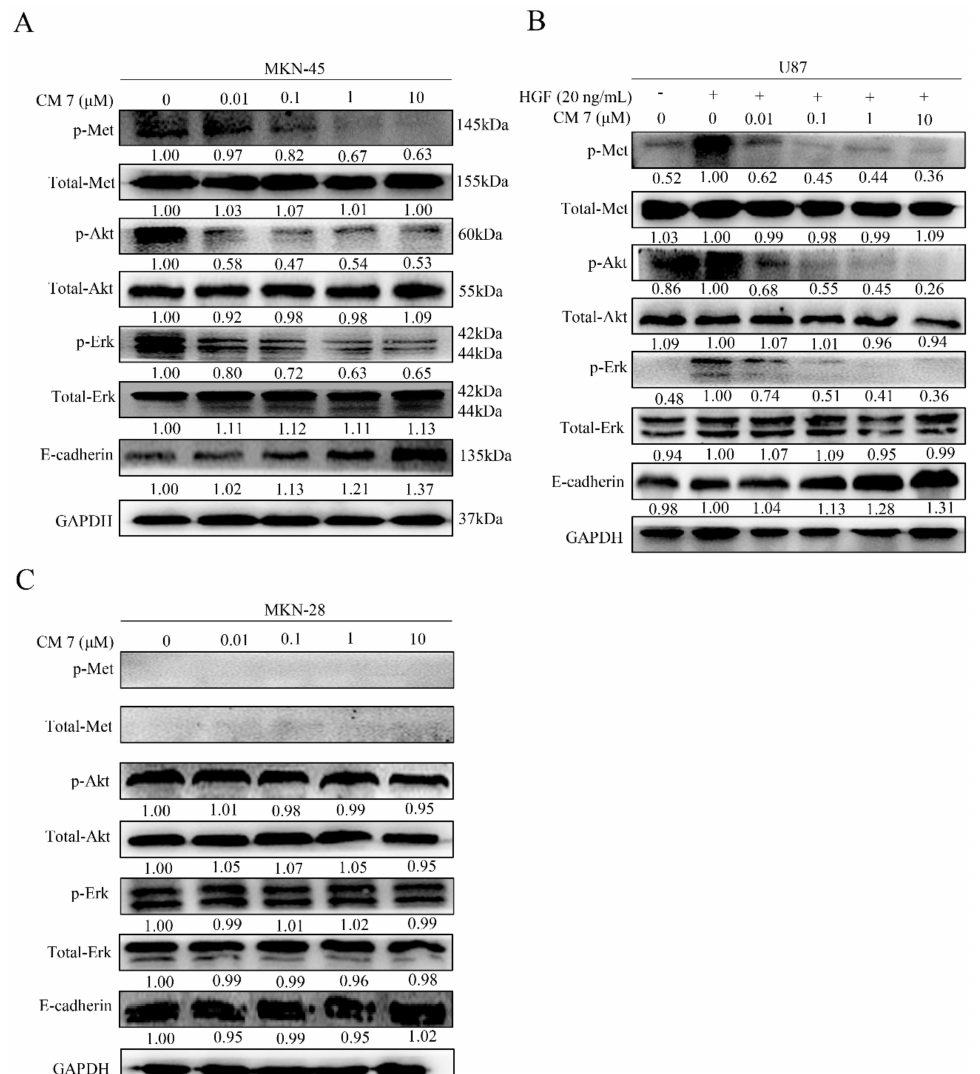
Figure 8. CM 7 inhibits c-Met phosphorylation and its downstream signaling molecules in di ff erent cells. ( A ) The phosphorylation of c-Met and downstream e ff ector molecules Akt and Erk was inhibited by CM 7 in MKN-45 cells. MKN-45 cells were treated with the indicated concentrations of peptide CM 7 for 24 h, and the lysate was subjected to Western blot. ( B ) CM 7 suppresses HGF-induced c-Met phosphorylation and its downstream signaling molecules in U87 cells. U87 cells were treated with the indicated dose of peptide CM 7 for 24 h, stimulated without or with HGF for 15 min, then Western blot was performed to detect the proteins, as shown in the picture. ( C ) CM 7 had no e ff ect on c-Met and its downstream signaling molecules in MKN-28